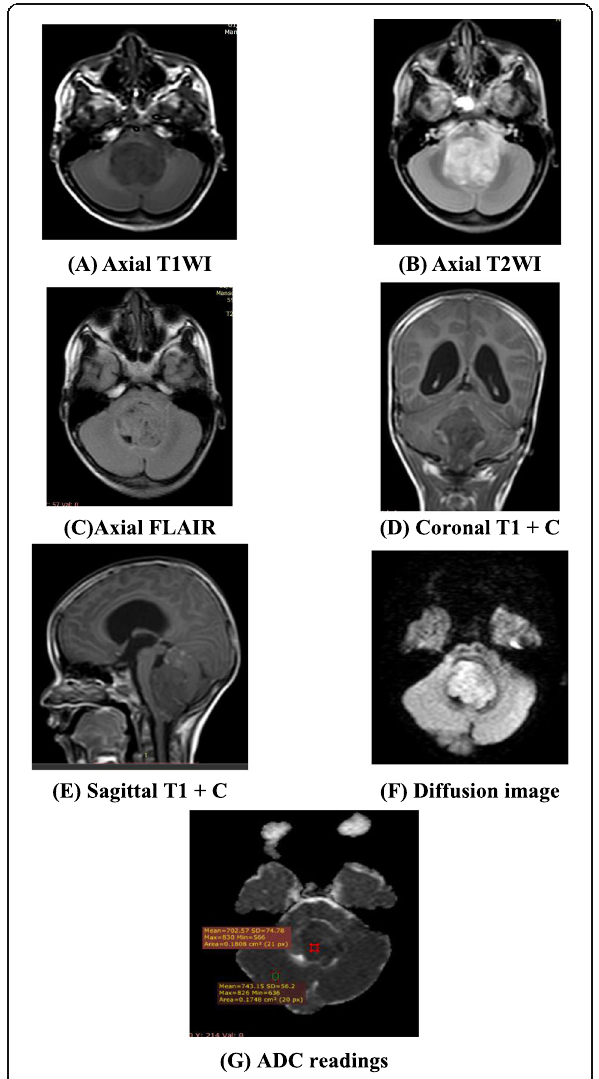
Fig. 4 A 4-year-old male patient complaining of vomiting. Axial T1 ( a ), axial T2 ( b ), axial FLAIR ( c ), coronal T1 ( d ), sagittal T1 ( e ) — posterior fossa midline SOL measured 45 × 40 × 40 mm at its AP, width, and CC diameters originating from the superior medullary valum and encroaching upon the 4th ventricular cavity with subsequent supratentorial hydrocephalic changes, hypointense to CSF on FLAIR, and exhibits inhomogeneous enhancement. Axial DWI ( f ), Axial ADC ( g ) — the lesion showed restricted diffusion, ADC ratio — 0.9, ADC values of the lesion (0.693, 0.702, 0.709) × mm 2 /s, average 0.702 × 10 3 mm 2 /s, ADC value of the normal cerebellum — (0.742, 0.743, 0.749) × 10 3 mm 2 /s, average 0.743 × 10 3 mm 2 /s that are consistent with medulloblastoma confirmed by